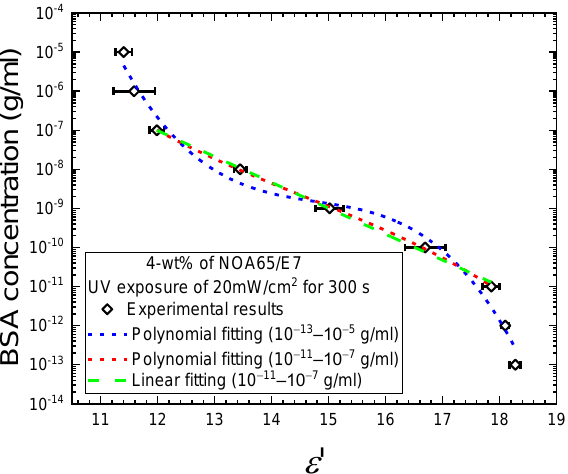
Figure 8. The BSA concentration as a function of the measured dielectric value, allowing interpolation of the concentration of the protein analyte in the dielectric permittivity range between 11.4 and 18.3. The blue and red dashed curves are third-order polynomial functions describing the relation of ε’ to BSA concentration in the wider 10 −13 –10 −5 g/mL and the narrower 10 −11 –10 −7 g/mL range, respectively. The green dashed line represents the result of linear regression in the BSA concentration range of 10 −11 –10 −7 g/mL. Table 1. Polynomial coefficients (in g/mL) in Equation (4) obtained through curve fitting of the experimental data as given in Figure 8. c Range